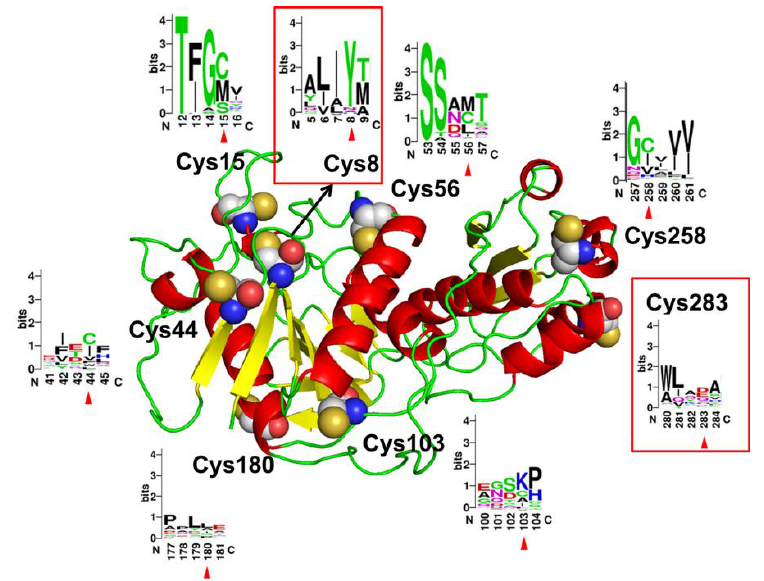
Figure 1. Structure model of AsA monomer. Eight cysteine residues are shown in spheres and the relative frequencies of each amino acid at the corresponding sites are shown with WebLogo 3.